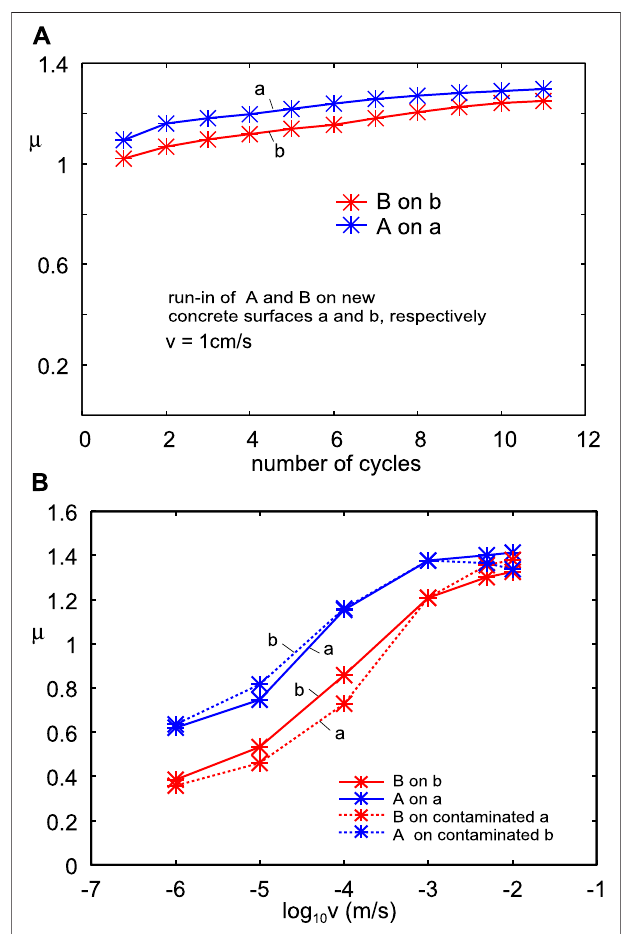
FIGURE 13 | (A) The friction coef fi cient at the sliding speed v (cid:1) 1cm / s asafunctionofthenumber ofslidingcyclesforcompound B(red)and A(blue) slidingontwodifferentconcreteblocksdenoted a and b ,respectively. (B) The friction coef fi cient as a function of the logarithm of the sliding speed. The solid lines are for the compound B (red line) and A (blue line) sliding on two different concrete blocks ( b and a , respectively) after run-in on the same concrete blocks (resulting in “ contaminated ” concrete surfaces). The red dashed line is for compound B sliding on the concrete block a after it was contaminated by the compound A. The blue dashed line is for compound A slidingon the concrete block b after itwascontaminated bythe compound B.